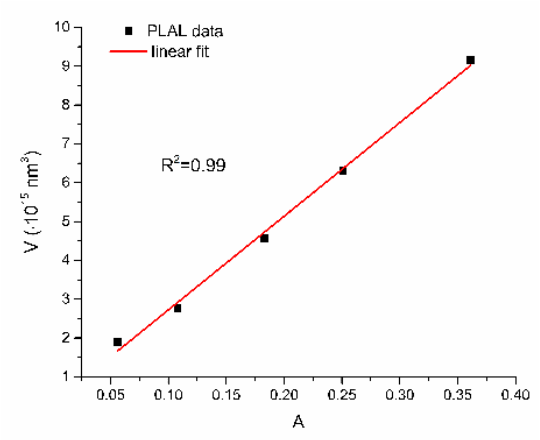
Figure 15. Dependence of crater volume on peak SPR absorbance for PLAL data obtained by the authors. With permission from Springer from [20].